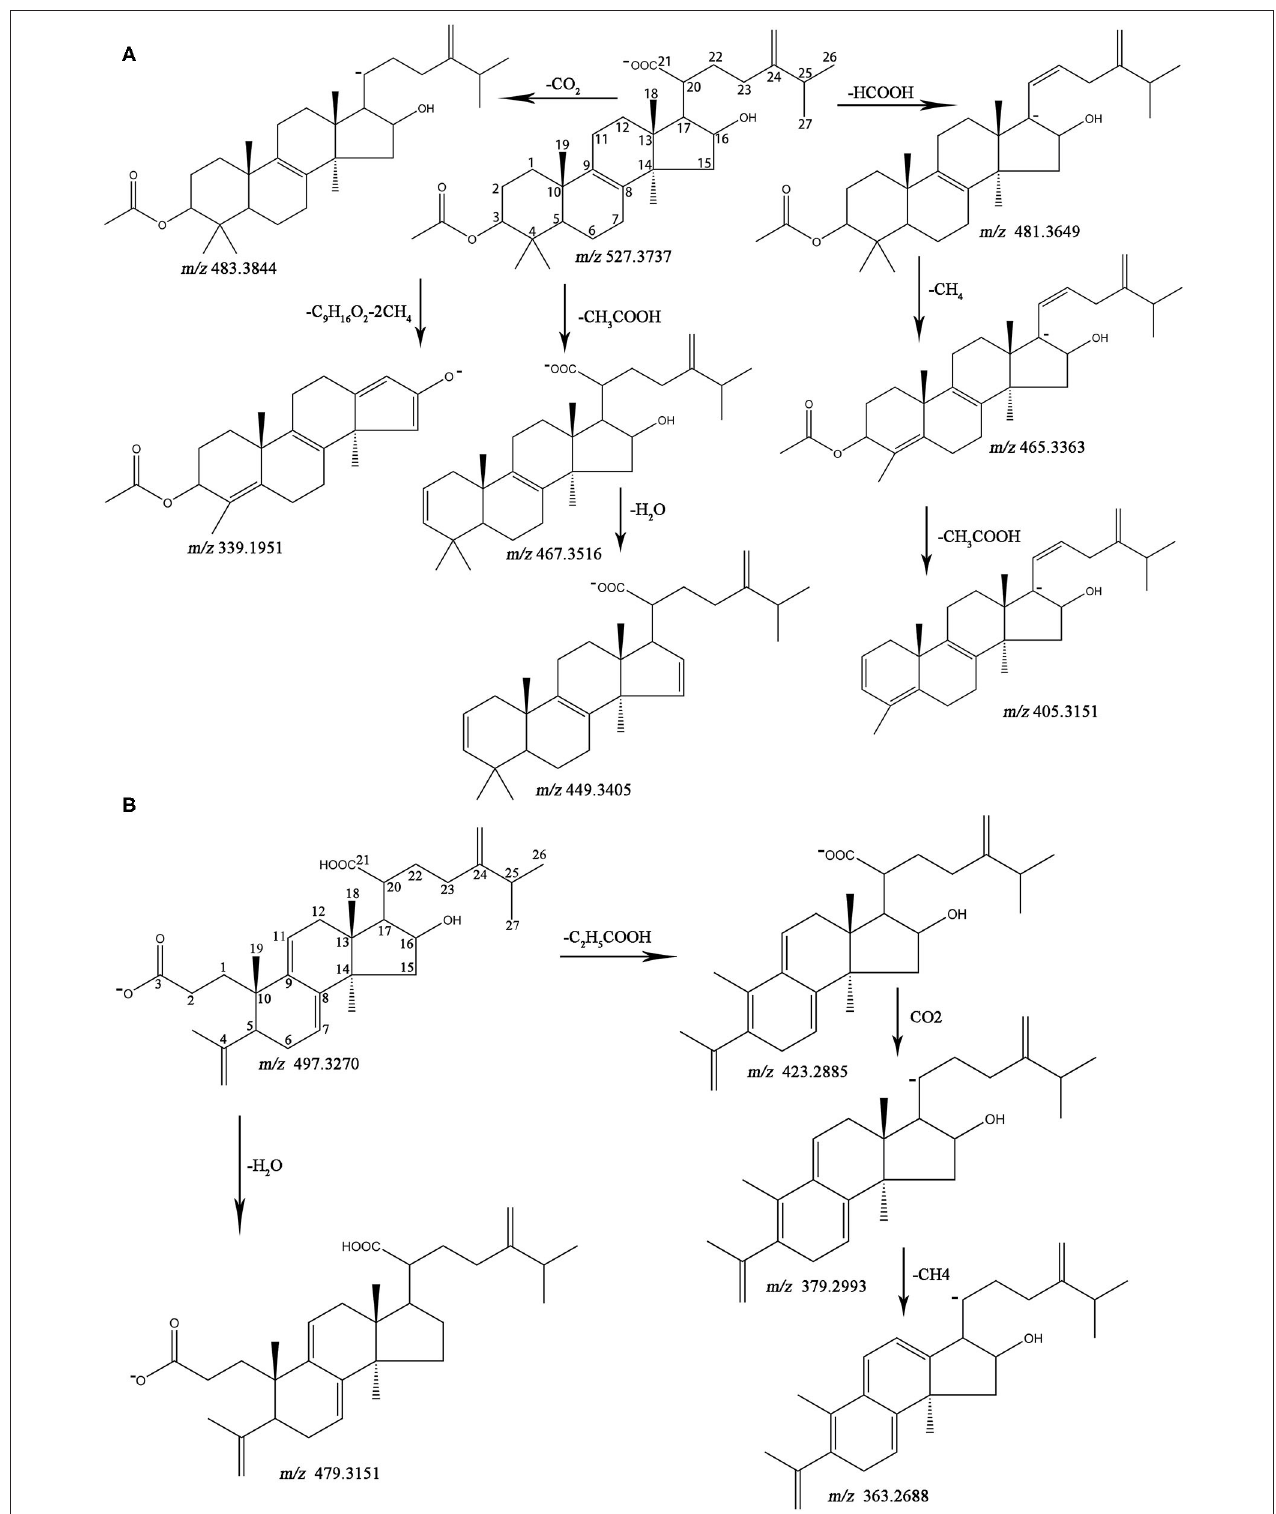
FIGURE 3 | The fragmentation pathways for pachymic acid (A) and porioic acid A (B) in ESI − .